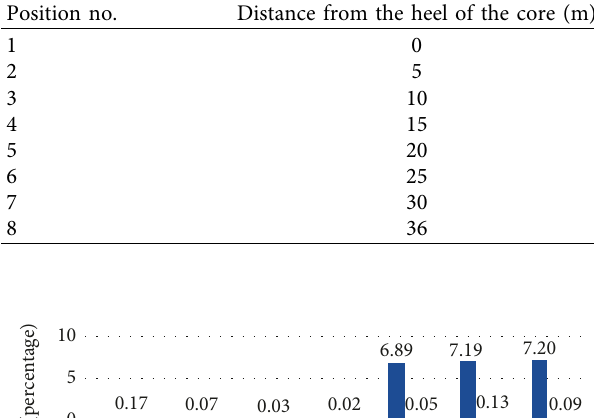
Table 6: Different positions of the cutoff wall (considering the length of 10 meters of the cutoff wall). Position no.